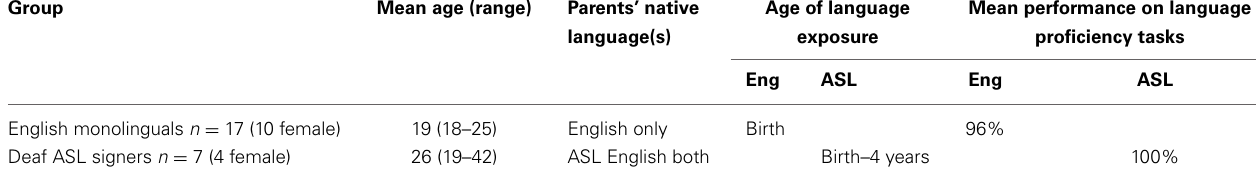
Table 1 | Participant groups’ ages and language background and participant information. Group